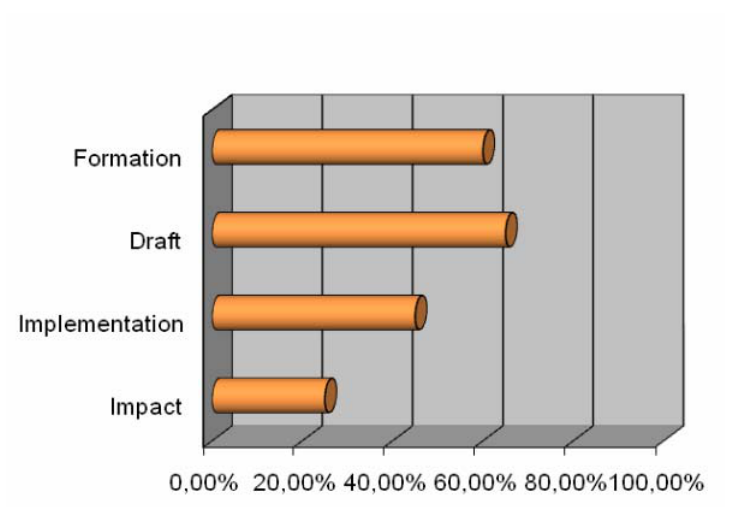
Figure 3: Phase of Legislation Process (MOMENTUM White Paper, June 2009)